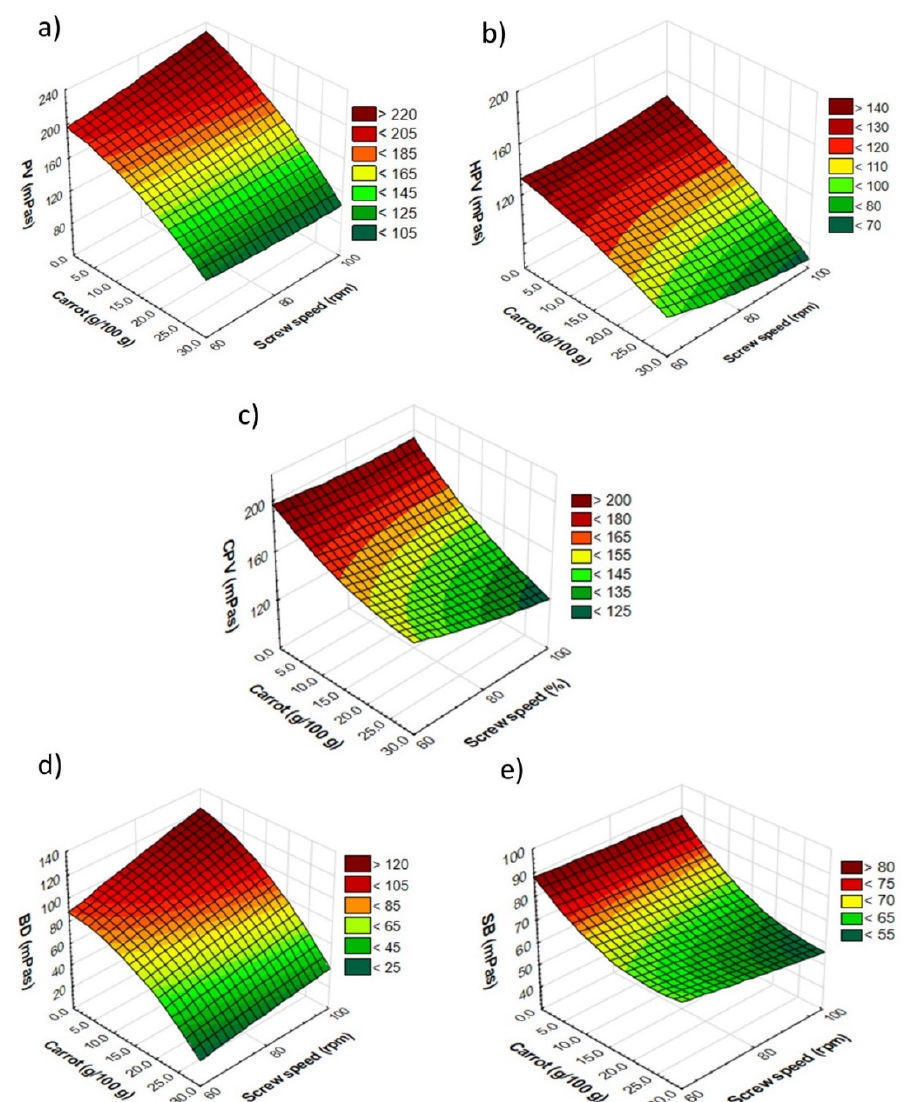
Figure 4. Results of pasting properties of extruded pellets enriched with fresh carrot pulp: ( a ) PV—peak viscosity, ( b ) HPV—hot paste viscosity, ( c ) CPV—cold paste viscosity, ( d ) BD—breakdown, ( e ) SB—setback.